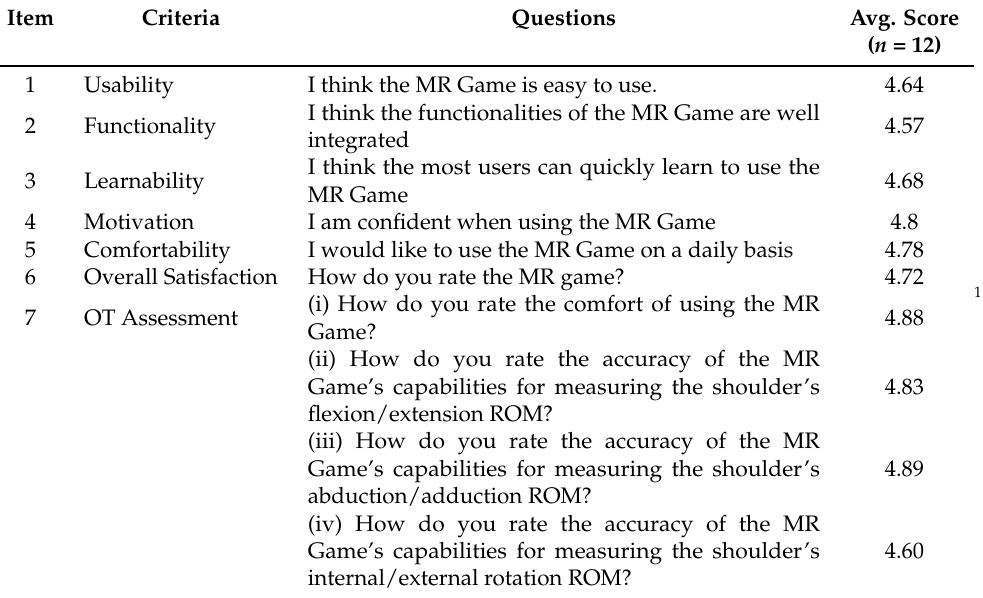
Table 3. Evaluation and OT assessment of the proposed MR-based gamified rehabilitation system, n = 12 (10 Healthy participants and 2